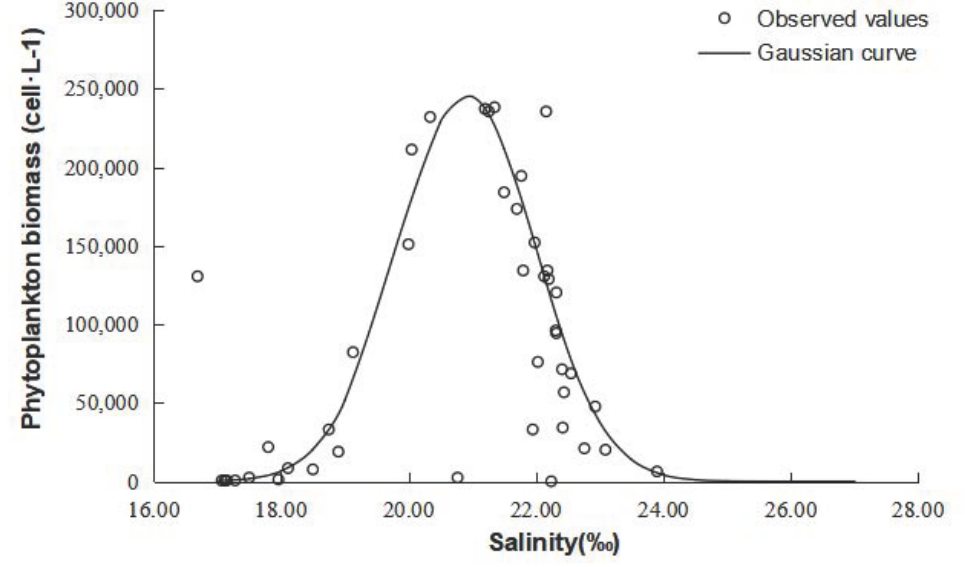
Figure 8. Gaussian curve and observed values: The Gaussian curve drawn according to Equation (6) fitted well with actual phytoplankton biomass and could adequately illustrate the tolerance of phytoplankton to the salinity.